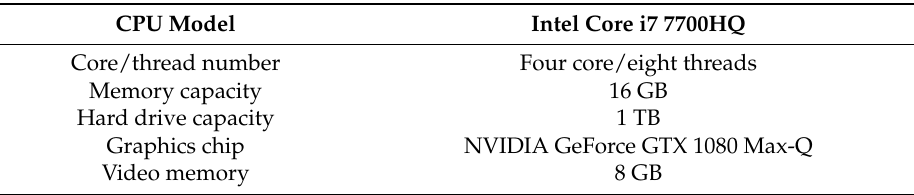
Table 1. Computer Table 1. Computer configuration. Table 1. Computer configuration.